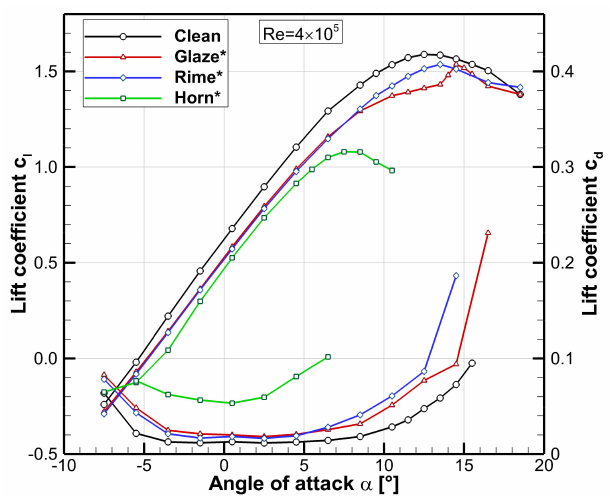
Figure 7. Experimental results for lift and drag of the LEWICE ice shapes for Re = 4 × 10 5 .